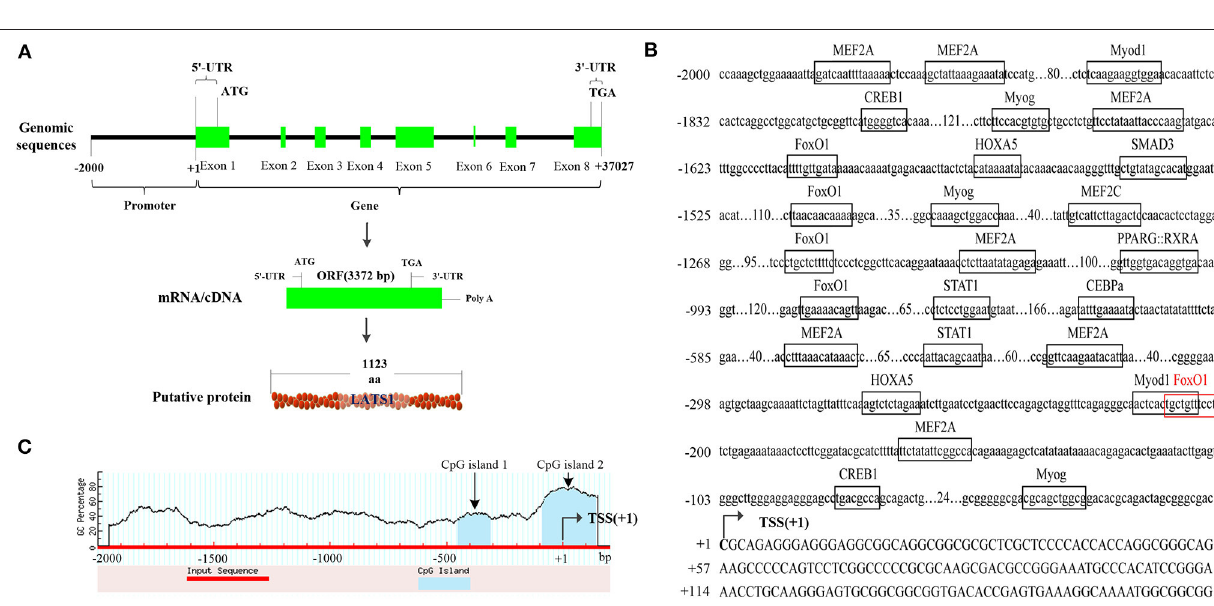
FIGURE 2 | Structural characteristics of the bovine LATS 1 gene. (A) The detailed genomic, mRNA, and protein components are containing the 5 ′ /3 ′ -untranslated region (5 ′ /3 ′ -UTR) and the open reading frame (ORF). (B) 5 ′ -regulatory region sequence of the bovine LATS 1 gene. Arrows mark the transcription initiation sites. The transcription factor binding sites are boxed. (C) Dashed lines indicate the GC percentage as represented on the y-axis and the x-axis denotes the bp position in the 5’-untranslated region. Coordinates are given relative to the translational start site (shown as +